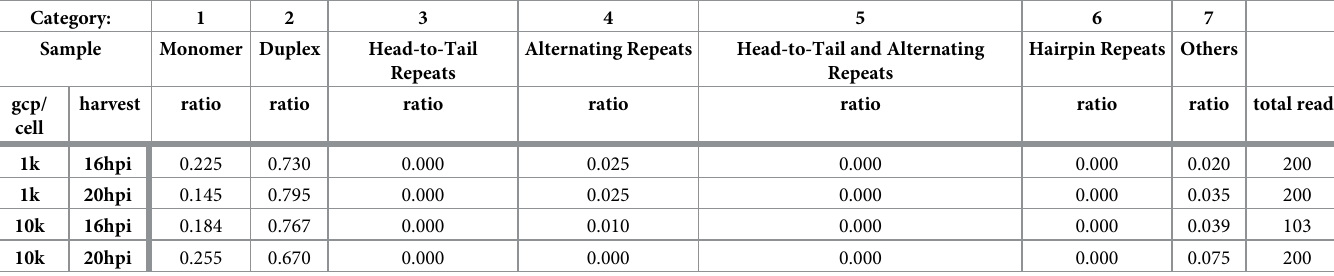
Table 3. Read analysis data from extrachromosomal MVM sequences isolated from MVM infected A9